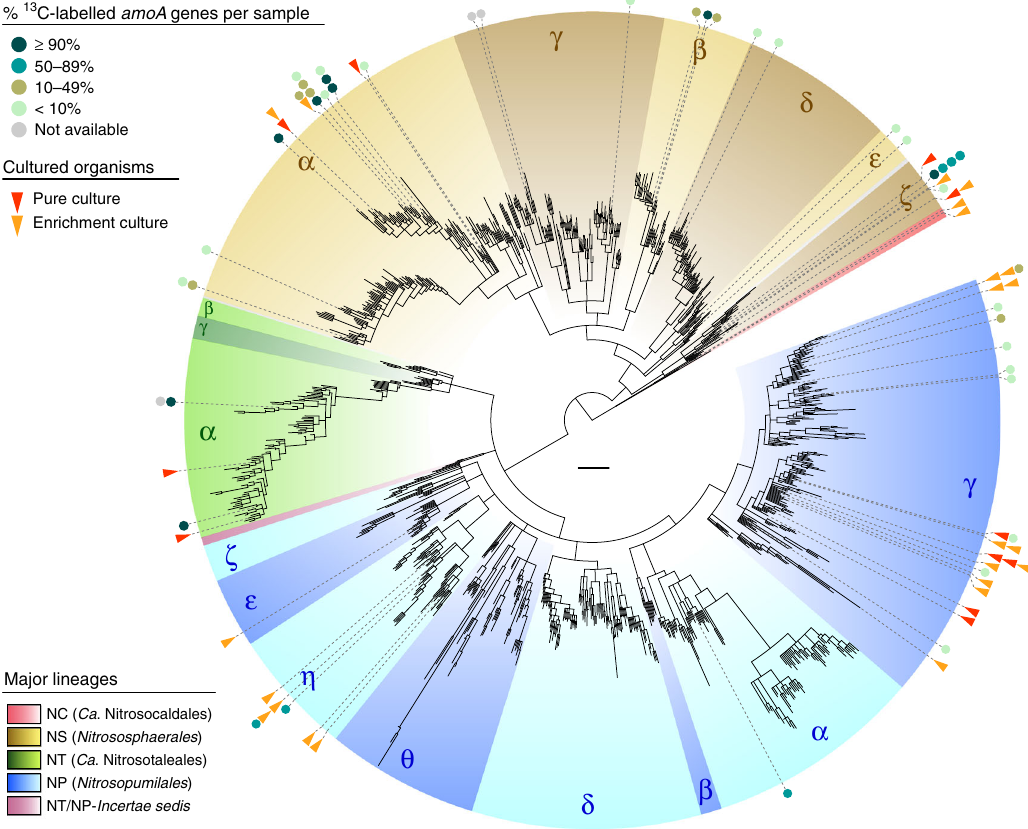
Fig. 5 Phylogenetic distribution of evidence for autotrophic growth and ammonia oxidation among AOA. Phylogenetic placement of amoA genes of AOA in pure (red triangles) or enrichment culture (orange triangles) with NH 3 and CO 2 as sole energy and carbon sources, respectively, and representatives of 13 C-labelled amoA genes from 12 published 13 C-CO ≥ 96% 2 stable isotope labelling (SIP) experiments (circles). All 44 sequences represented share identity with their corresponding reference sequence in the tree. Filled circles indicate representative sequences and are coloured according to relative abundance of associated amoA genes among all 13 C-labelled amoA genes obtained from the corresponding sample. The scale bar represents 0.1 substitutions per nucleotide position. References for cultivated strains and SIP studies included are shown in Supplementary Tables 1, 2. See legend of Fig. 1 for tree